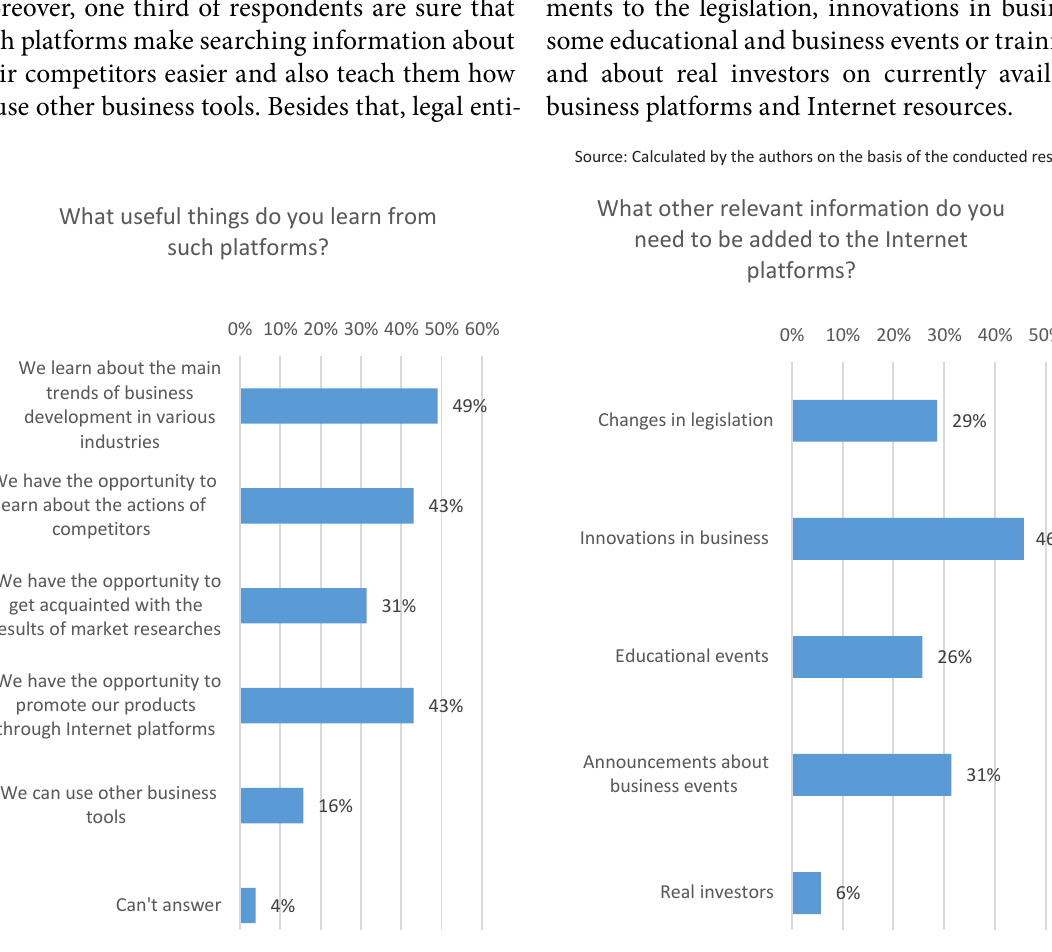
Figure 8. The respondents’ answers to questions that determine the importance of information presented by the Internet platforms (multiple